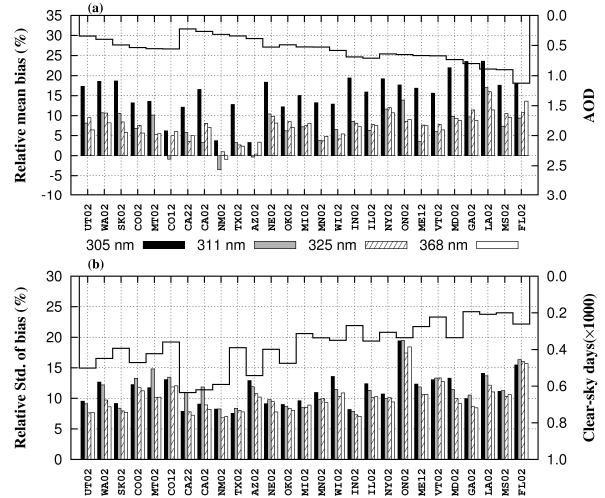
Fig. 2. The relative mean (a) and standard deviation (b) of biases ( left axis ) of the 2000–2004 summer (May-September) noontime surface UV irradiances at 305, 311, 325, and 368nm under clear- sky conditions using the TRT (TOMS reflectivity threshold) cloud screening method during 2000–2004. Also shown as the top curves ( right axis ) are total optical depth (aerosol plus cloud) at 368nm (a) and total number of clear-sky days